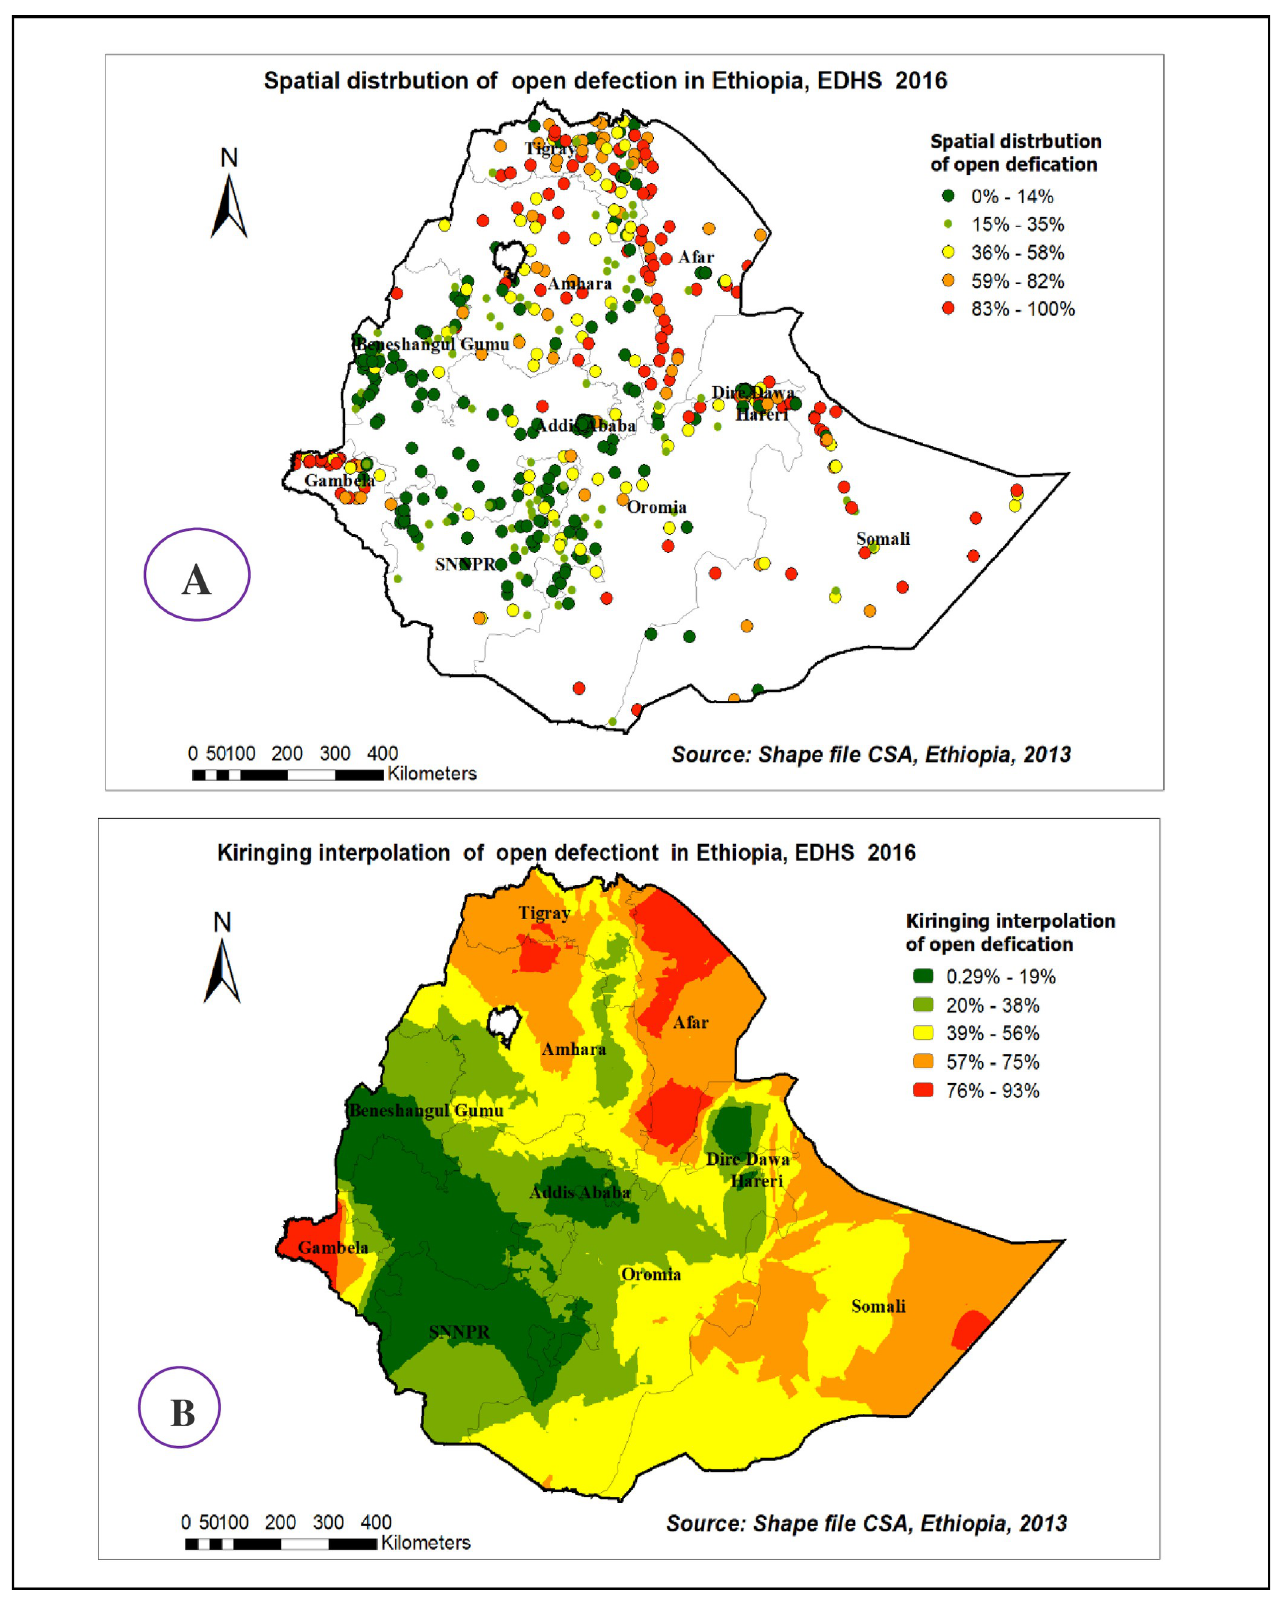
Fig 5. Spatial distribution (A) and interpolation(B) of open defecation in Ethiopia EDHS 2016 plotted using ArcMap 10.7. https://doi.org/10.1371/journal.pone.0268342.g005 PLOS ONE | https://doi.org/10.1371/journal.pone.0268342 May 19,